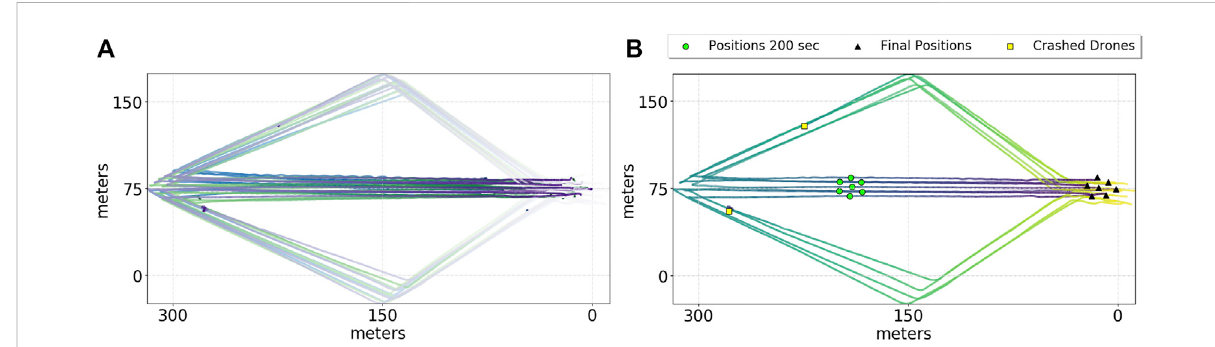
FIGURE 4 Trajectories of 9 UAVs performing a diamond-shaped trajectory during real experiments. The color of the trajectory becomes lighter with the fl ow of time; a lighter color represents the initial phase, while a darker color denotes the fi nal phase of the experiments. The top plot (A) shows a superposition of the trajectories performed by each UAV over three different experiments. The bottom plot (B) analyzes one single particular experiment where two different crashes on two different units were experienced and highlighted here as yellow